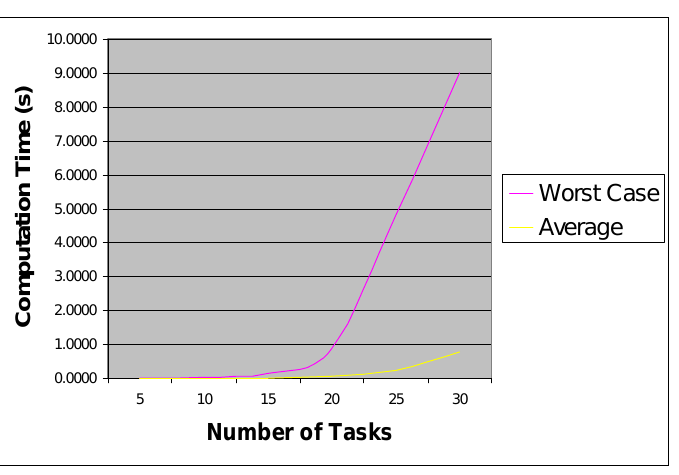
Figure 13. SWAPFIT running times.